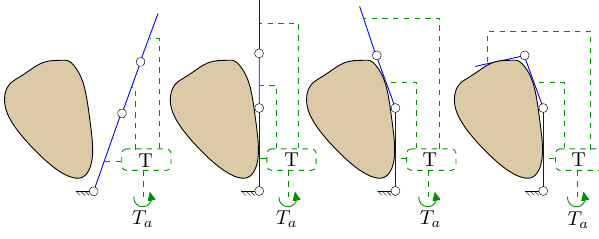
Figure 6. Closing sequence of a three-phalanx finger keeping its phalanges